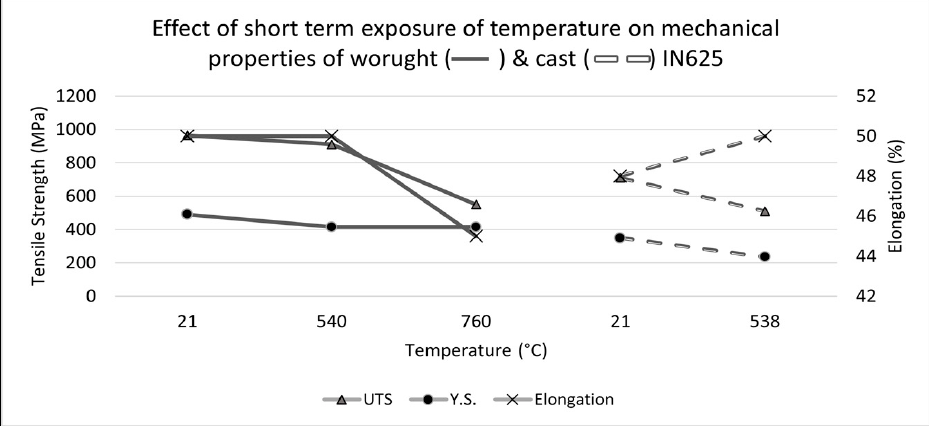
Figure 3. E ff ect of temperature on short-term mechanical properties (tensile) of the cast (data from Ref. [1])and wrought (data from Ref. [2]) IN625.